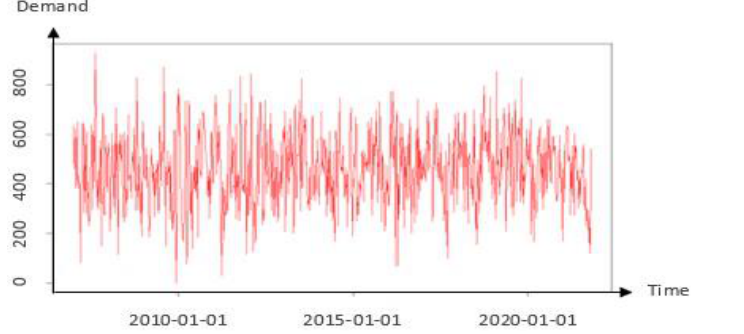
Figure 9. Case study weekly demands over time.